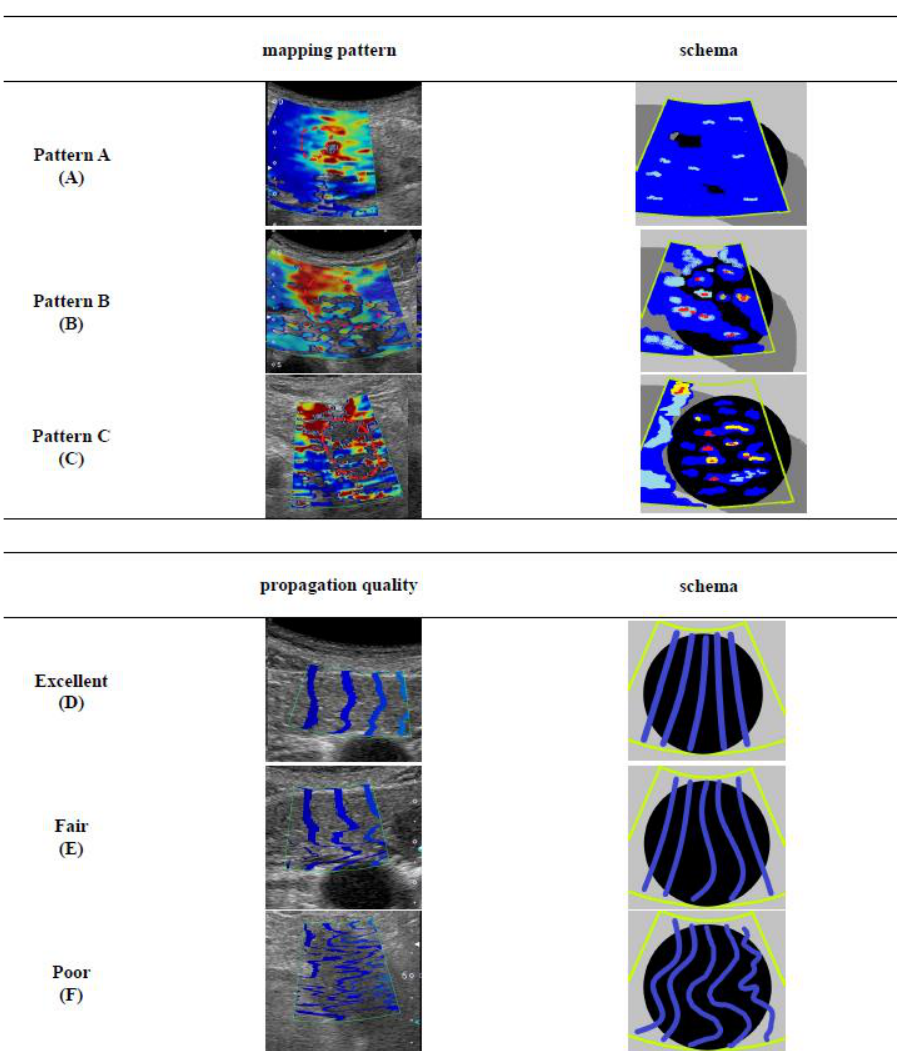
Figure 1. The definitions of shear wave elastography (SWE) mapping patterns and propagation qualities: ( A ) Mapping pattern A, whole coloring over the tumor/non-tumor lesion; ( B ) Mapping pattern B, presence of partial coloring area (major color-displayed area showing 50% or more of the target lesion) and small isolated coloring spots (major color-displayed area showing less than 50% of the target lesion) and uncolored in the other part; ( C ) Mapping pattern C, multiple small isolated coloring spots (major color-displayed area showing less than 50% of the target lesion) with uncolored areas; ( D ) Propagation quality “Excellent”, linear contour lines are with equally spaced intervals; ( E ) Propagation quality “Fair”, some of the lines are showing unequally spaced and/or non-linear appearance; ( F ) Propagation quality “Poor”, all lines are demonstrating a non-linear appearance with non-linear shaped lines.